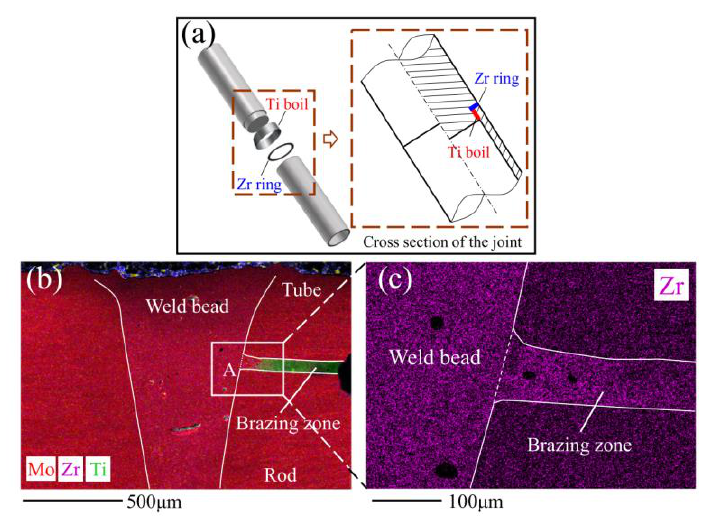
Figure 12. Tracing of the metal elements in the weld bead of the Mo-0.03Ti-B joint: ( a ) schematic diagram of the location where Zr was added. ( b ) Analysis of Mo, Zr, and Ti on the cross section of the joint by EDS surface scanning. ( c ) Analysis of Zr in zone A in panel ( b ) by EDS surface scanning. [10].